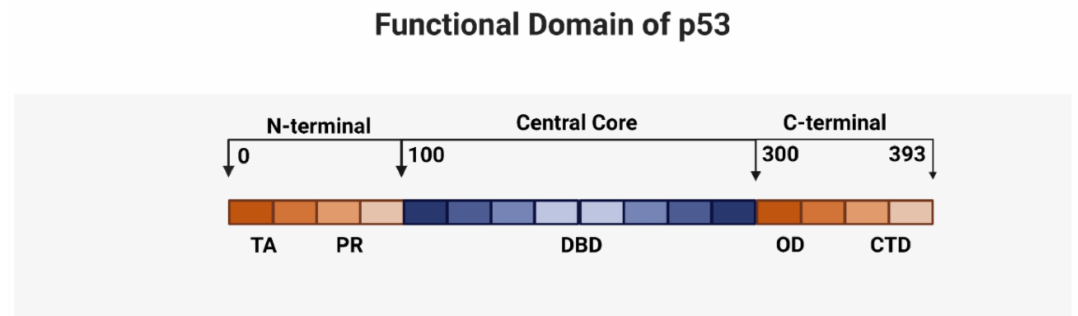
Figure 1. Functional domain of p53: The N-terminal portion consists of the transactivation domain (TA) and the proline rich domain (PR). TA is required for transactivation of various transcription factors and interaction of MDM2 ubiquitin ligase. The central core is mainly made of the DNA—binding domain (DBD); most of the exons of TP53 are sequenced. The C—terminal consists of the oligomerization domain (OD) and the carboxy- terminal regulatory